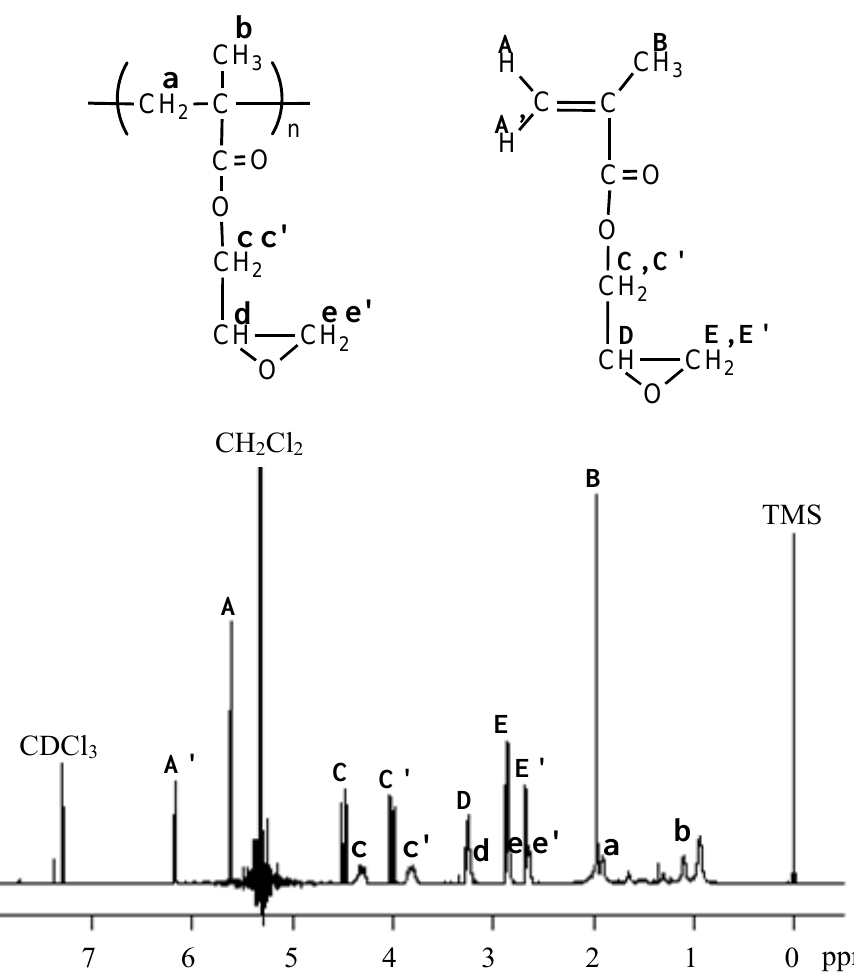
Figure 1. The 1 H NMR spectrum of the product containing the monomer and resulting polymer obtained by the MTEMPO-mediated photopolymerization. Solvent: CDCl